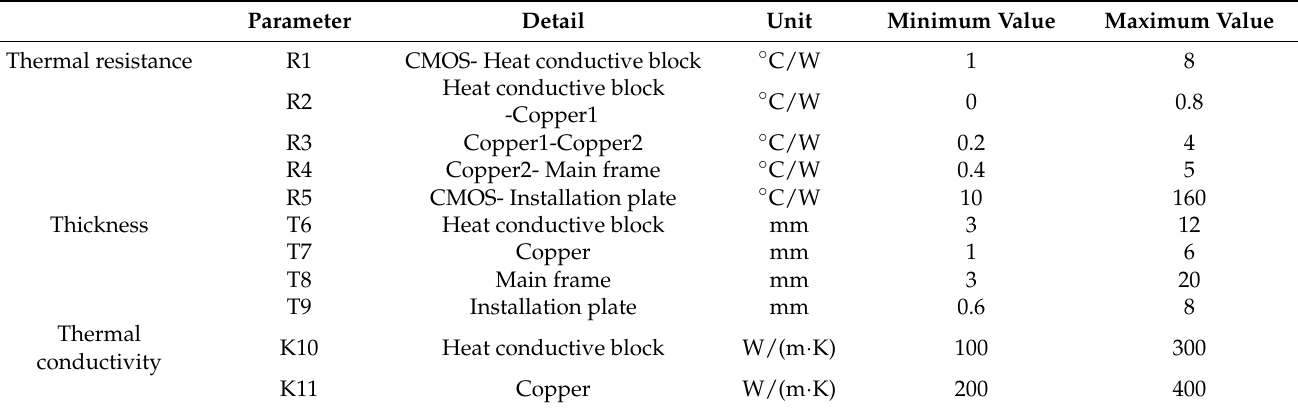
Table 3. Parameters to be